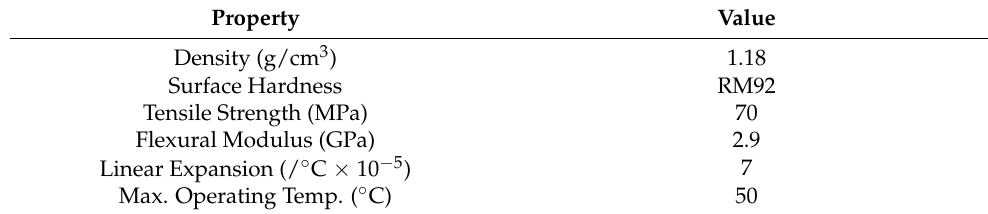
Table 1. Material properties of PMMA.